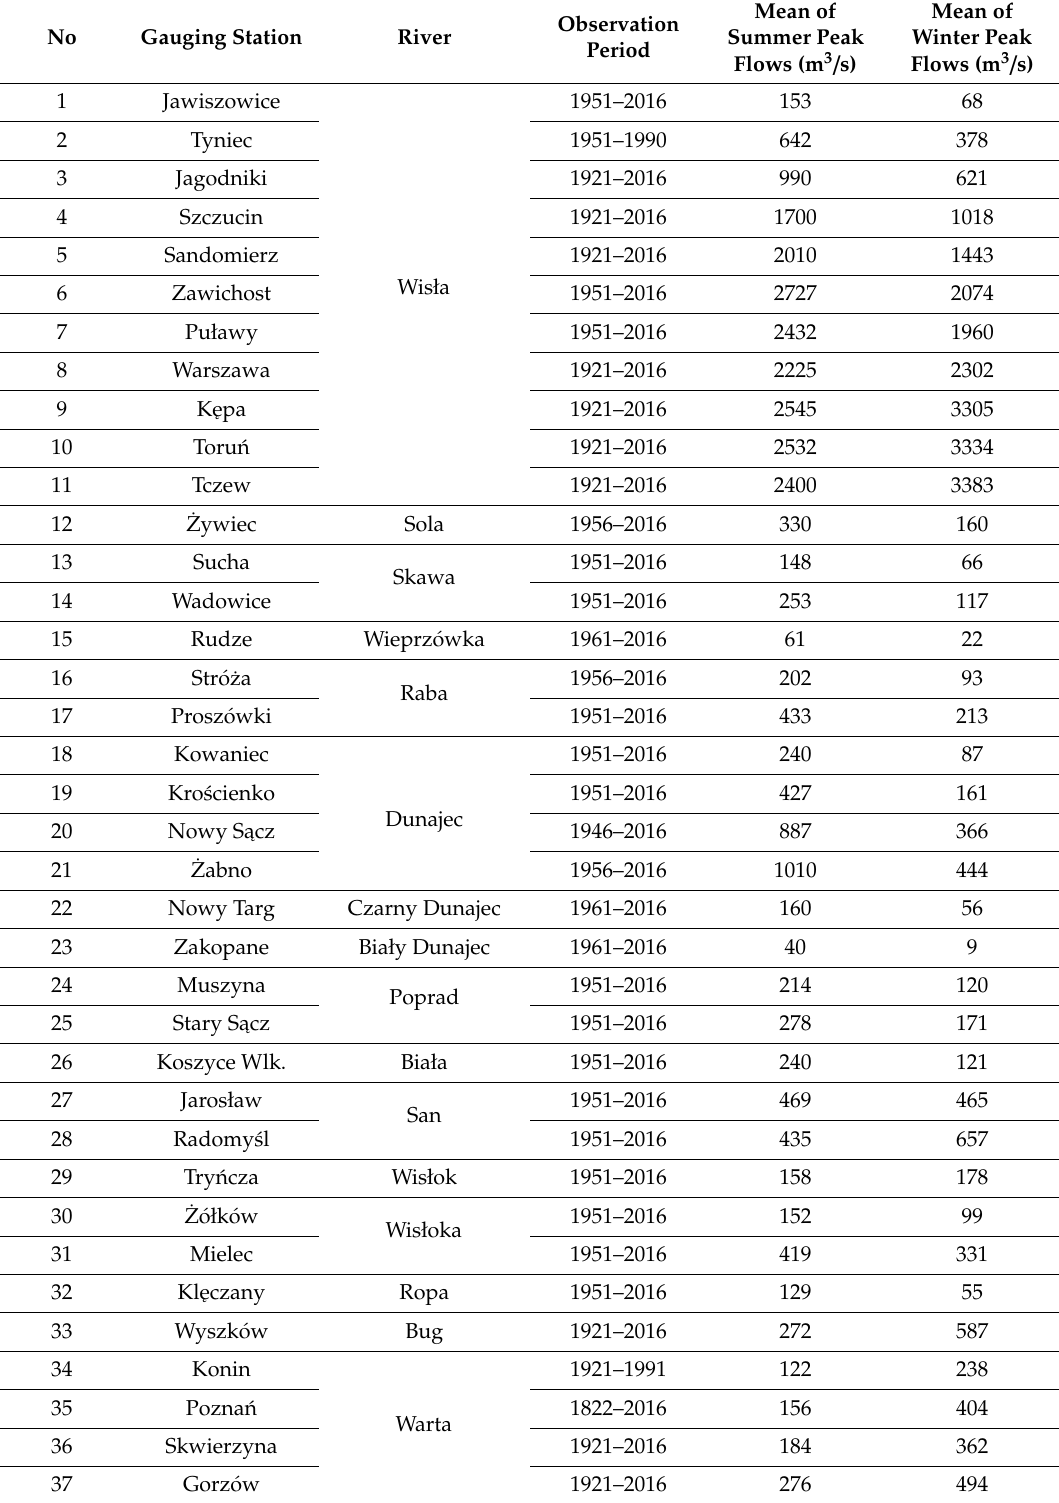
Table A1. Basic characteristics of the seasonal peak flows of 37 gauging stations at Polish rivers analyzed in